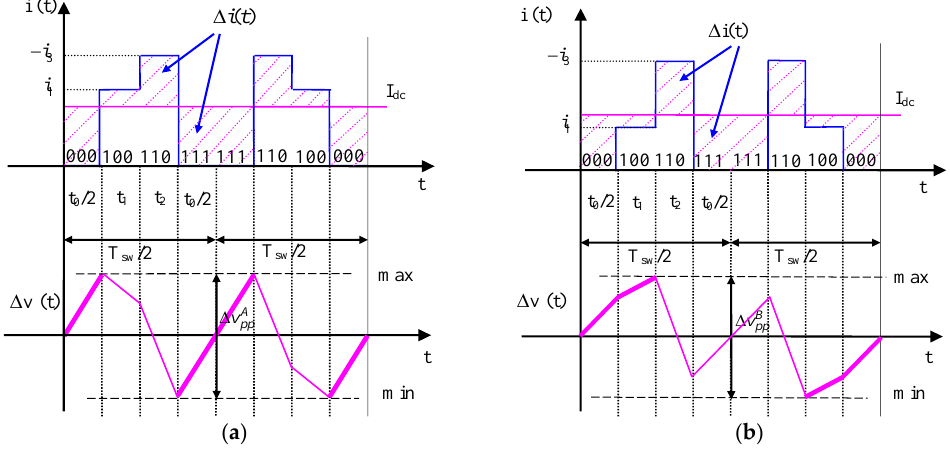
Figure 3. dc-link current and voltage ripple in one switching period: ( a ) Case A (0 ≤ ϑ ≤ π /3, i 1 ≥ I dc ), ( b ) Case B (0 ≤ ϑ ≤ π /3, i 1 < I dc